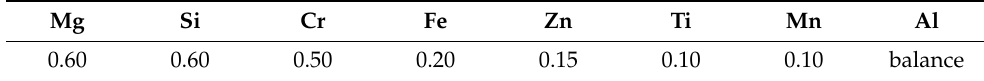
Table 1. Chemical composition of the studied alloy (wt%).